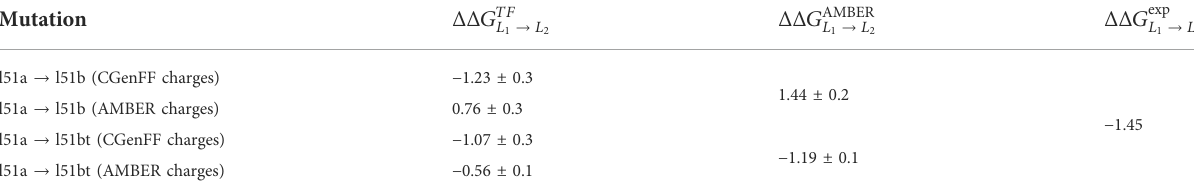
TABLE 4 ΔΔ G bind L in kcal/mol for the alchemical transformations of l51a into the two tautomeric forms of ligand l51b/l51bt of the FXa dataset. TF 1 → L 2 denotes results obtained with transformato. Values for ΔΔ G AMBER